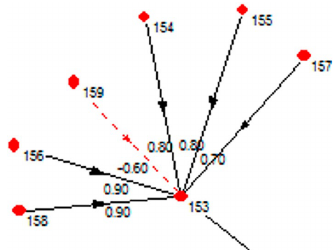
Figure 7. Quantification of relationships Source : Carlucci et al. (2014: